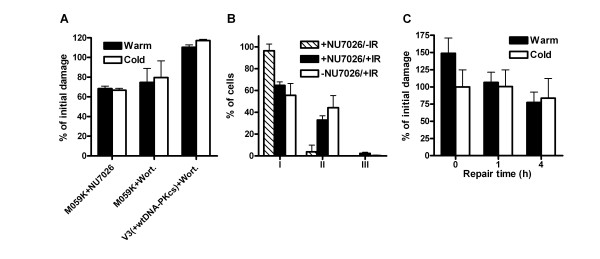
Inhibition of DNA-PKcs autophosphorylation does not result in ssDNA formation. (A) The catalytic activity of DNA-PKcs was inhibited by 50 μM NU7026 or 50 μM wortmannin in M059K cells and V3+wild type DNA-PKcs cells. At 4 h after irradiation the DNA was extracted either with the warm or the cold protocol and the number of DNA fragments was detected by PFGE. The number of DNA fragments detected at 0 h by the cold protocol was set to 100%. The error bars represent the maximum deviation of two experiments (M059K+NU7026), the standard error of the mean of three experiments (M059K+Wortmannin), and the maximum deviation of duplicates from one experiment (V3+wt DNA-PKcs). (B) BrdU corresponding to ssDNA was detected 4 h after irradiation in M059K cells treated with 50 μM NU7026 and cells were scored as in Figure 3. Irradiated M059K cells without NU7026 are plotted for comparison. At least 100 cells in three experiments were scored. (C) V3 cells expressing DNA-PKcs with six autophosphorylation mutated sites (ABCDE) were treated as in (A) after irradiation. Error bars represent the SD of at least three experiments.